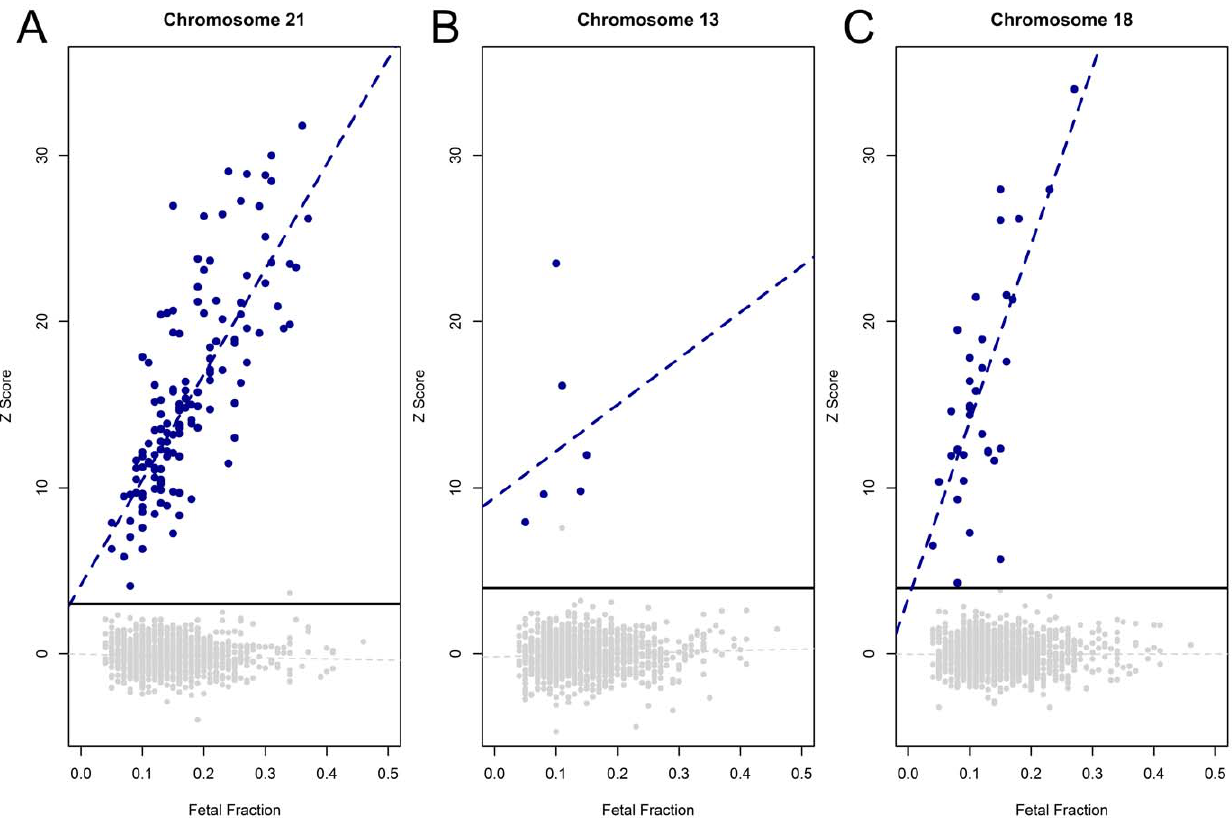
Figure 3. Z-score is linked to fetal fraction. The chromosome specific z-score for each aneuploid chromosome is plotted against the proportion of fetal DNA (fetal fraction). Samples classified by karyotype analysis as trisomies for A) Chromosome 21, B) Chromosome 13, or C) Chromosome 18 are shown in blue; unaffected samples for each aneuploidy condition are shown in gray. Black horizontal line in each plot represents the respective classification cutoff for each chromosome (z=3 for chromosome 21, z=3.95 for chromosomes 13 and 18). Dashed blue line in each panel represents a robust linear fit of aneuploid samples. Dashed gray line in each panel represents a robust linear fit of all unaffected samples.